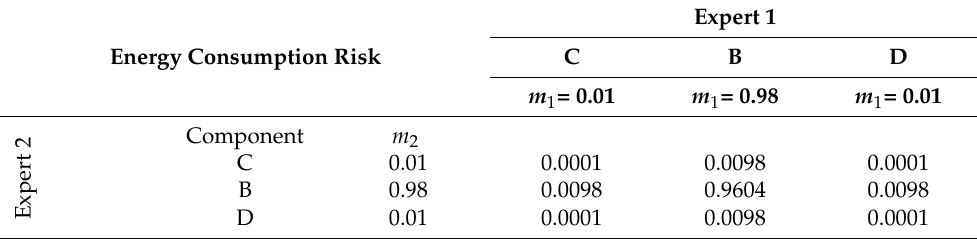
Table 8. Dempster combination of Expert 1 and Expert 2 for energy consumption risk.